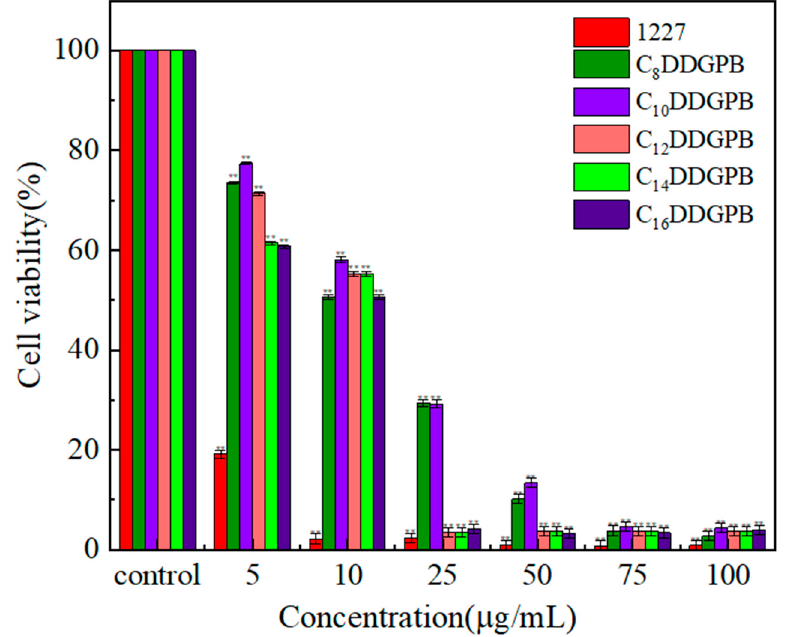
Figure 12. Changes in cell viability of HeLa cells and C n DDGPB cocultured for 48 h. (Note: compared with the respective control group).